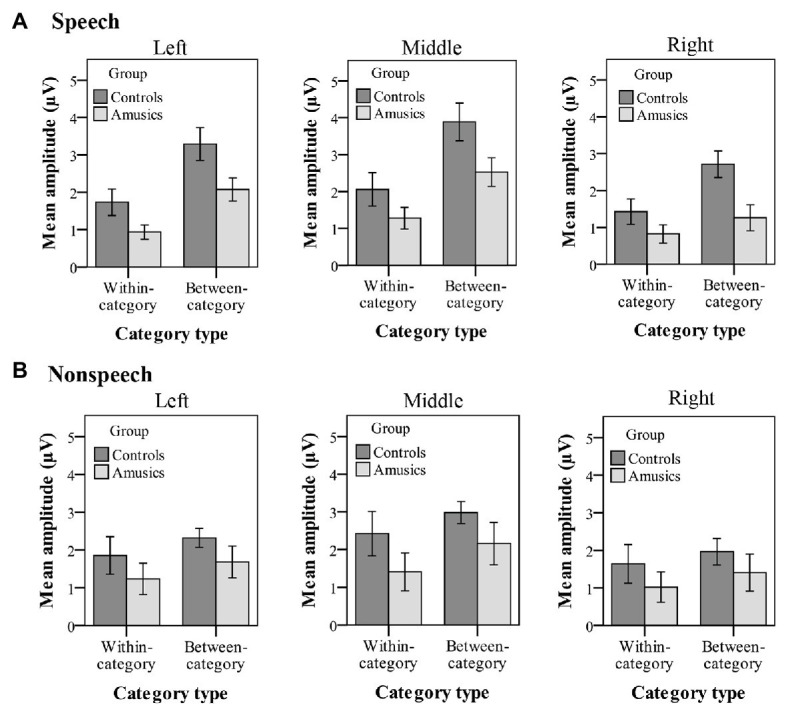
Mean P300 amplitude of within-category and between-category difference waves elicited in (A) speech stimuli and (B) nonspeech stimuli for both groups. The P300 amplitude was calculated from 320 to 600 ms by averaging the voltage measured at electrodes on the left hemisphere (P1, P3, P5, and PO3), in the midline (Pz, POz), and on the right hemisphere (P2, P4, P6, and PO4), respectively. Error bars: +/−1 standard error.